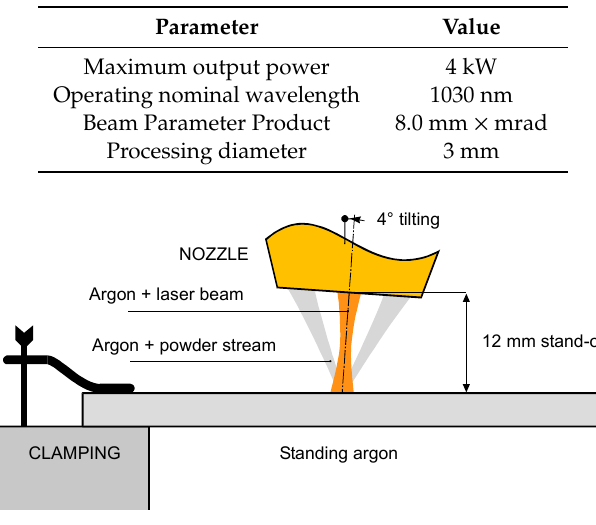
Figure 2. Scheme of the laser head with three-way feeding nozzle; components not to scale.